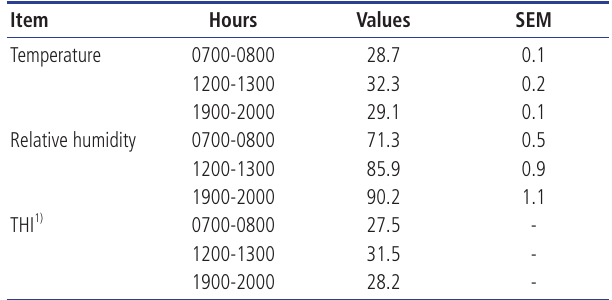
Table 2. Average diurnal morning, noon and evening temperature and humidity pattern in the experimental house (0700 to 2000) Item Hours